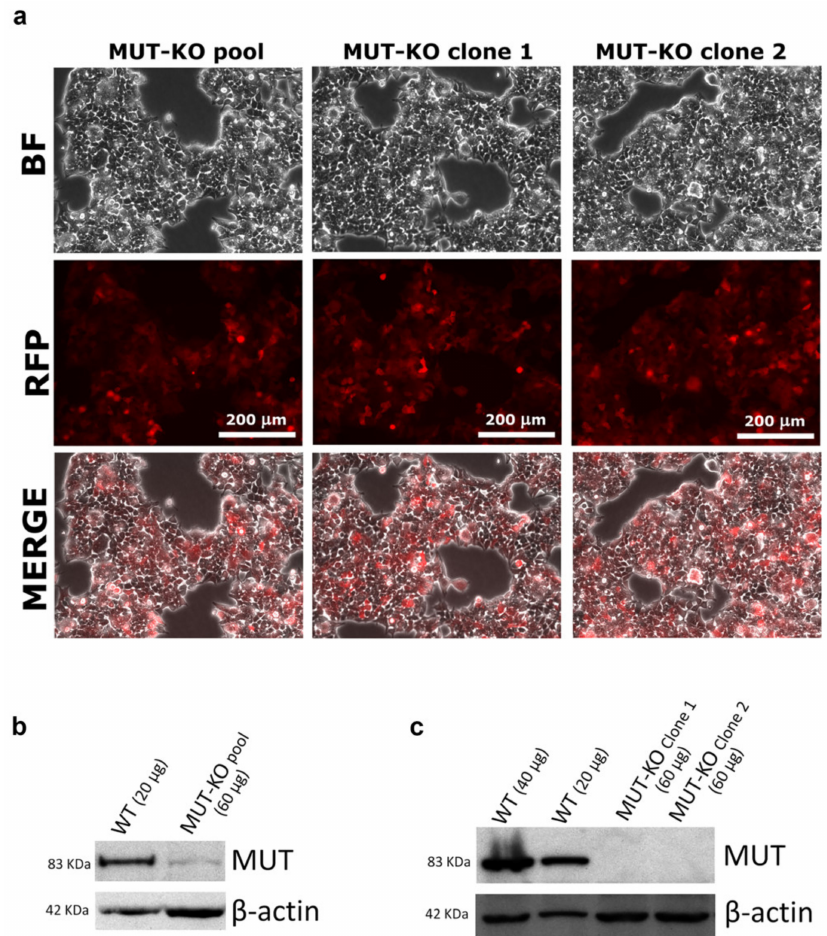
Figure 1. Analysis of HEK 293 cells after genome editing and culturing in a selective medium for methylmalonyl-CoA mutase knockout (MUT-KO). ( a ) Microscopy images of CRISPR / Cas9-modified cells. After transfection, cells were observed with a 20 × objective and images were acquired with the Leica LAS AF software. MUT-KO pool: Whole CRISPR / Cas9-transfected cell population after selection with puromycin. MUT-KO clones: Cell populations isolated from single progenitor cells within the MUT-KO pool. RFP: Fluorescence signal from the red fluorescent protein detected with a Leica N3 filter cube. BF: Phase-contrast bright field. The Western blot (WB) analysis of MUT levels in the ( b ) MUT-KO pool and ( c ) two single cell clones (namely, MUT-KO clone 1 and 2), isolated from the MUT-KO pool. In both WBs, wild type (WT) cells were used as a control of MUT expression; β -actin was used as the loading